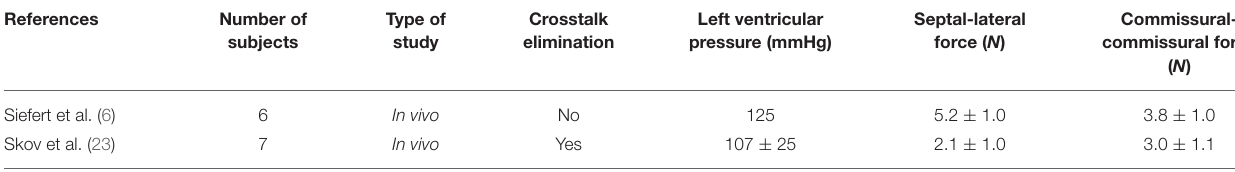
TABLE 2 | Overview of in-plane forces in the native mitral annulus.